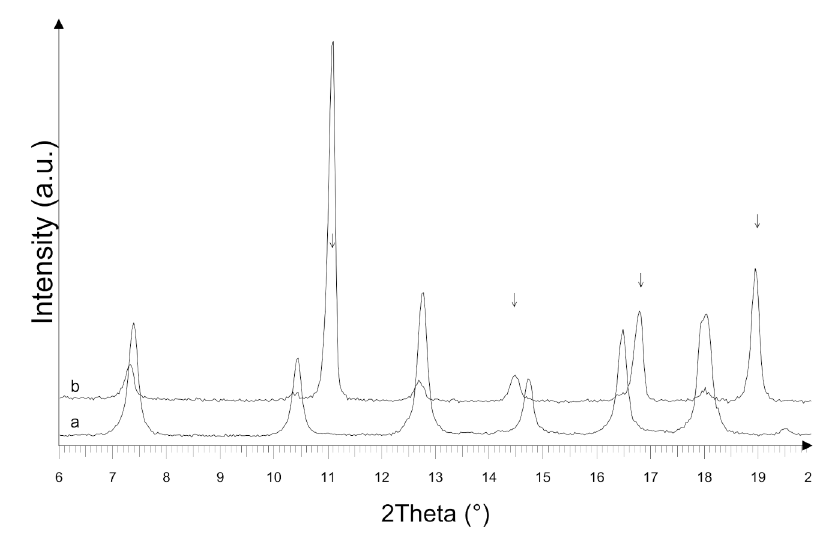
Figure 6. XRPD patterns of ZIF-8: As prepared (pattern a), after OFL adsorption at pH 8.1 (pattern b). The new peaks are indicated by arrows.